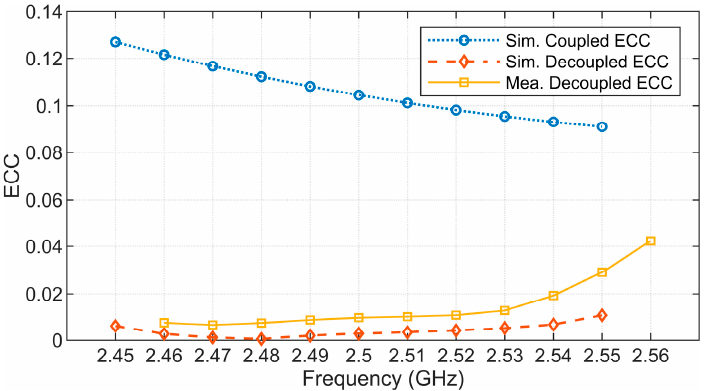
Figure 15. Envelope correlation coe ffi cient.